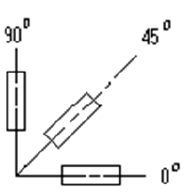
Figure 11. Schematic view of the strain rosette gage.